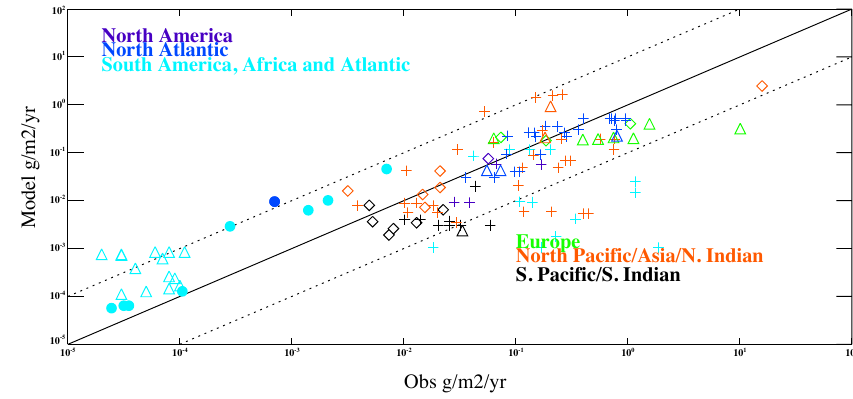
Fig. 12. Comparison between observed and modeled (present-day) iron concentration at a variety of sites (g/m 2 /year). The compiled observations are available from Mahowald, et al. (2009).